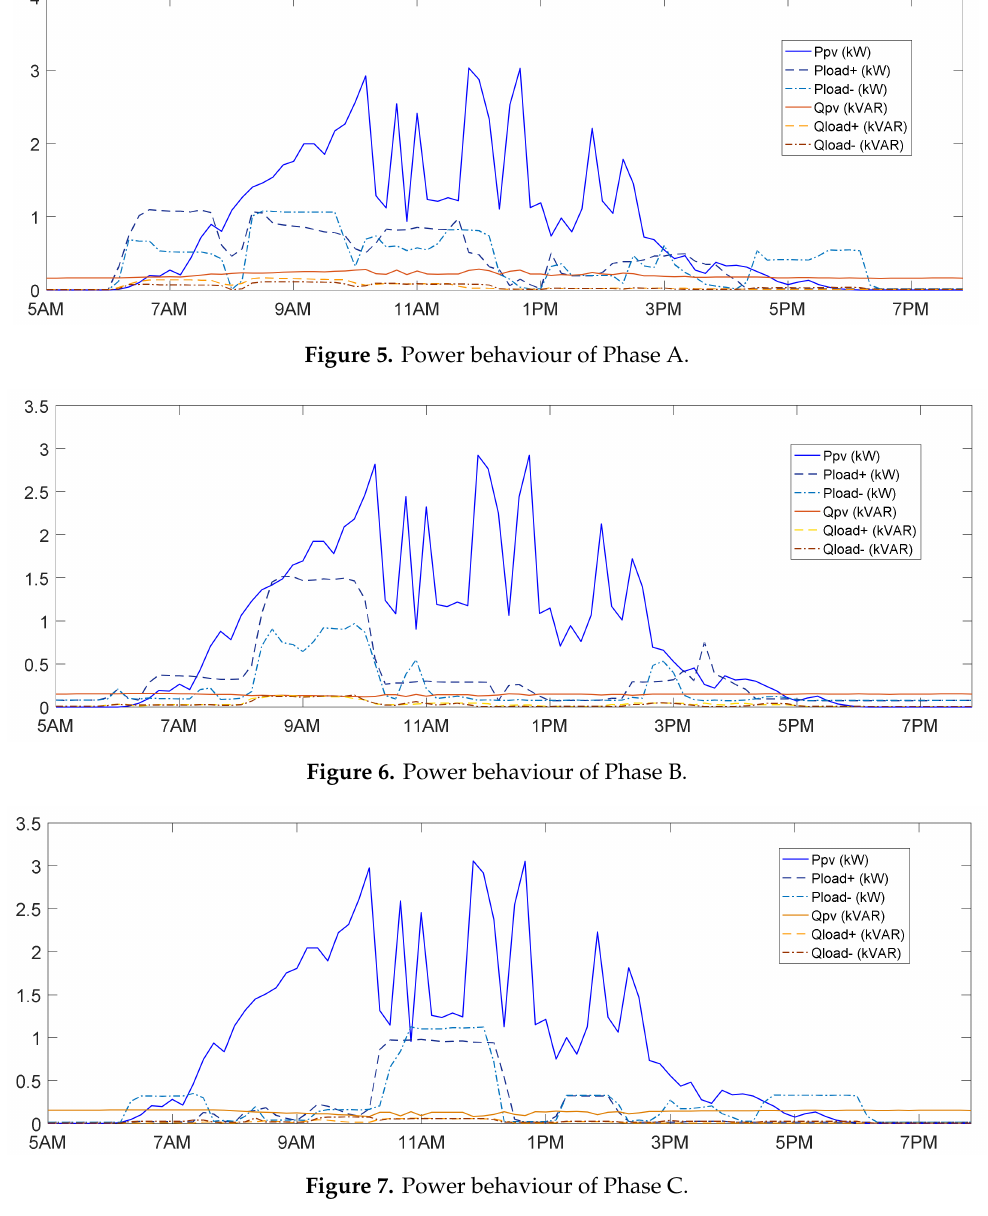
Figure 7. Power behaviour of Phase